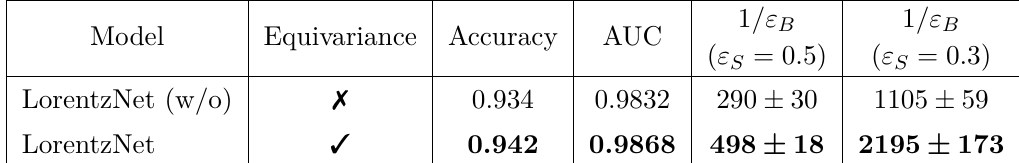
Table 4 . Performance comparison between LorentzNet and corresponding non-equivalent version on top tagging dataset. Both of the results are averaged on 6 runs.